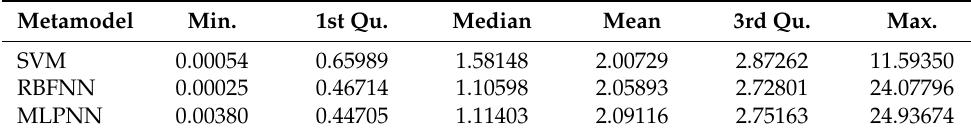
Table 3. Metamodeling error in feasibility index